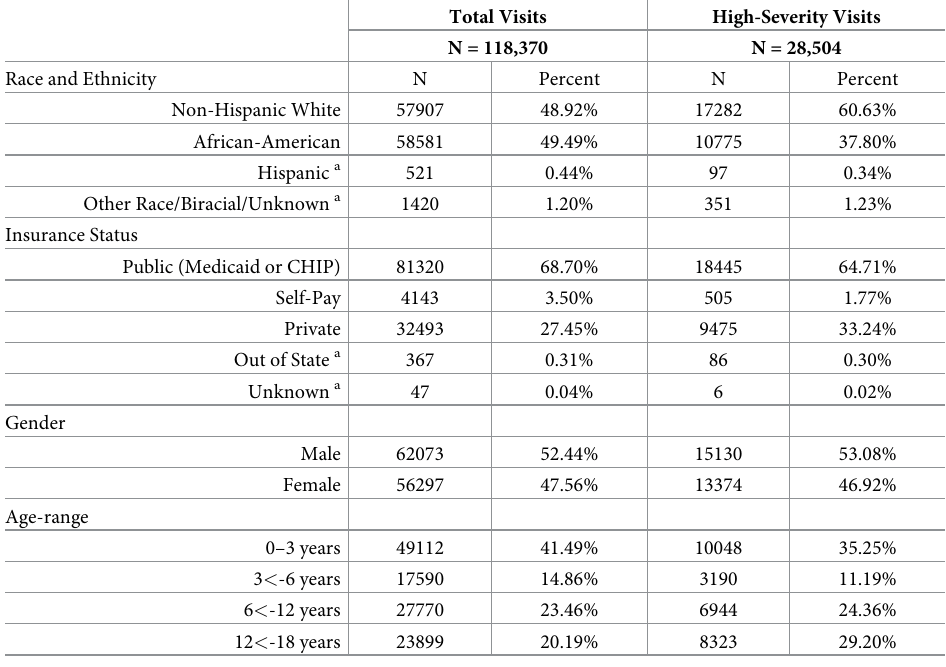
Table 1. Distribution of patient socioeconomic characteristics for pooled pediatric ED visits for Jan-Dec 2019 and 2020, Children’s of Alabama Emergency Department. Total